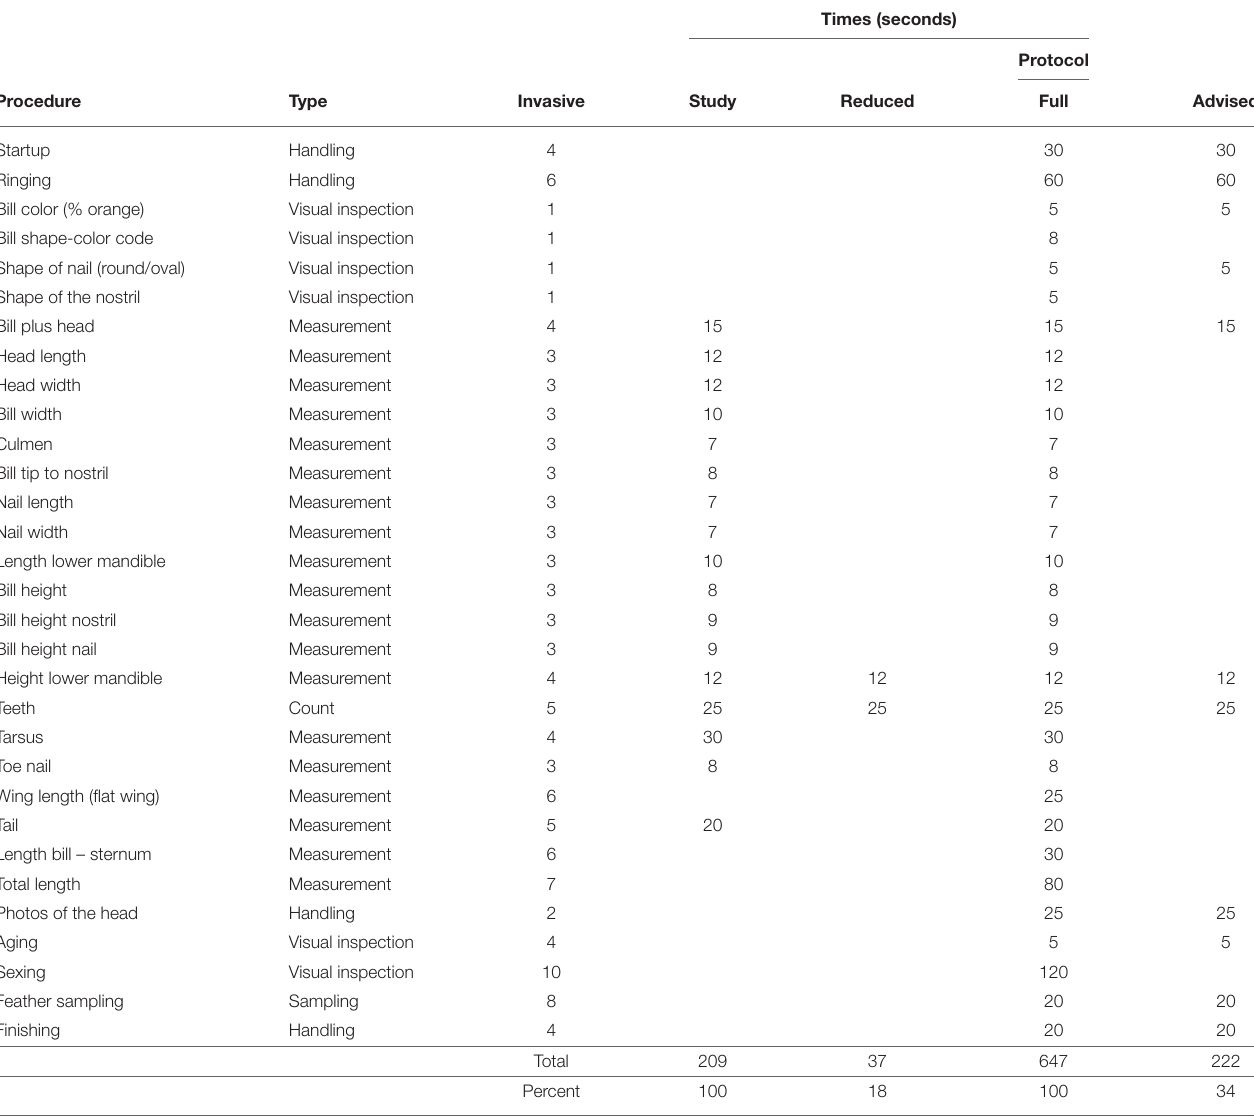
TABLE 8 | Estimated duration (seconds) for actions in this study and in protocols for Bean Goose catching operations, with potential reductions based on the results of this study.